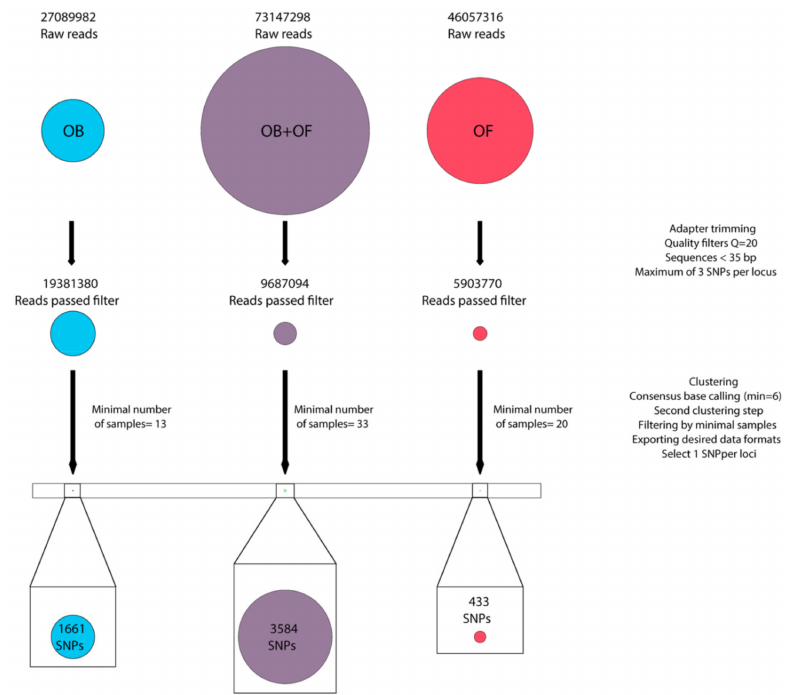
Figure 2. Graphical representation of the 3 analyzed datasets. Circles on the top represent the total amount of raw reads. After filtering steps, the circles sizes show the proportion of reads that passed each filtering step. The circles at the bottom represent the proportion of SNPs in the final matrix, zoomed in. OB = Osteoglossum bicirrhosum ; OF = Osteoglossum ferreirai